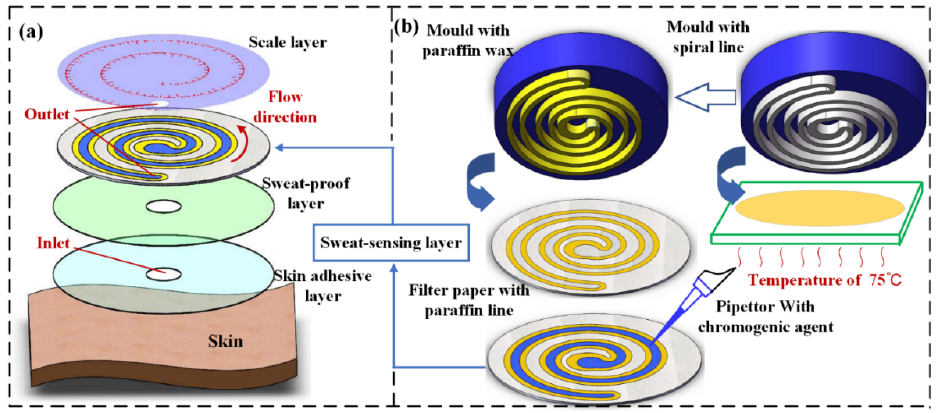
Figure 1. Structure of the paper-based sweat rate monitoring chip: ( a ) exploded view showing all layers of the whole chip, including the skin adhesive layer, sweat-proof layer, sweat-sensing layer, and scale layer; ( b ) method for fabrication of the sweat-sensing layer using a 3D-printed mold with a double-spiral structure.